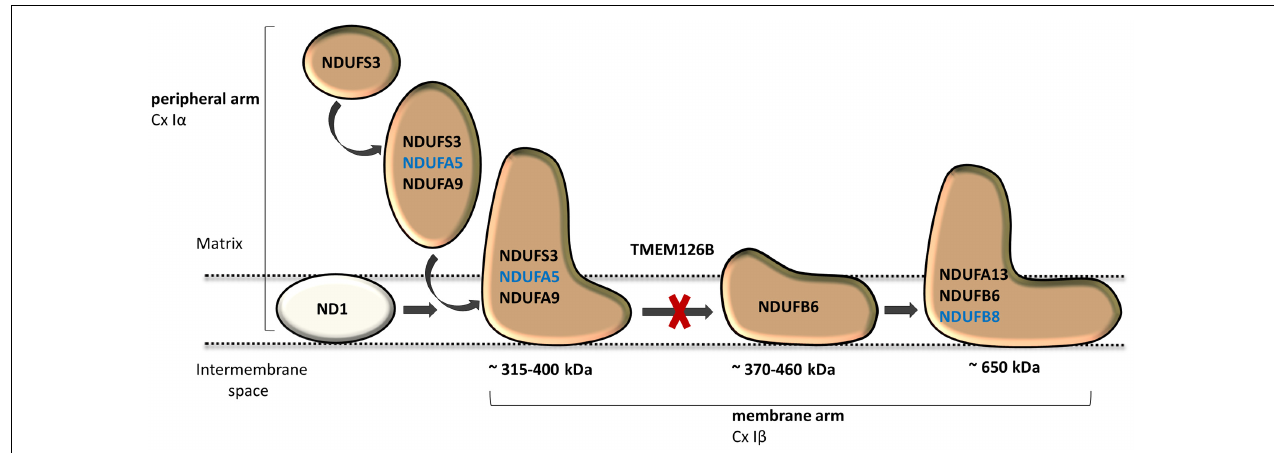
FIGURE 4 | TMEM126B functions as an early complex I assembly factor. TMEM126B is required for the joining of the ∼ 315 and ∼ 370 kDa assembly intermediates (previously estimated ∼ 400 and ∼ 460 kDa, respectively). BN-Page on TMEM126B defective patient fibroblasts indicated accumulation of NDUFA5 (Q-module) in the ∼ 315 kDa intermediate and a drastic decrease in complex I, indicating that part of the peripheral arm was missing. Membrane arm subunit NDUFB8 (N-module) was present in normal quantities in mature complex I, indicating that assembly of the complex I membrane arm succeeded despite missing parts of the peripheral